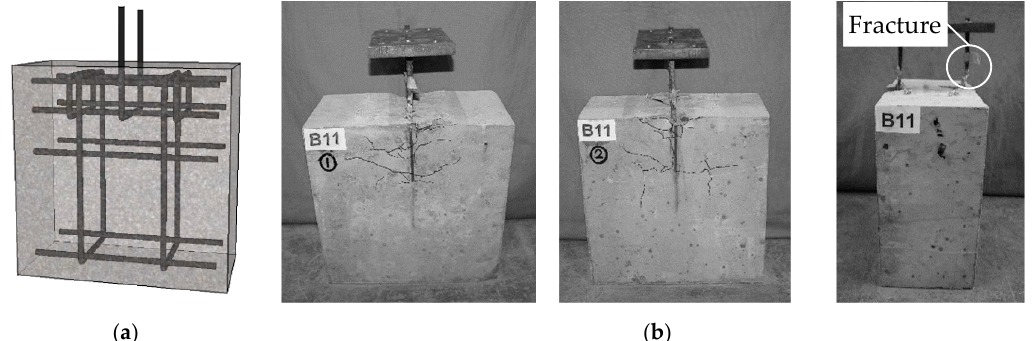
Figure 5. Crack and failure mode of interval arrangement in Group B. ( a ) Interval arrangement; ( b ) Crack pattern of B11.